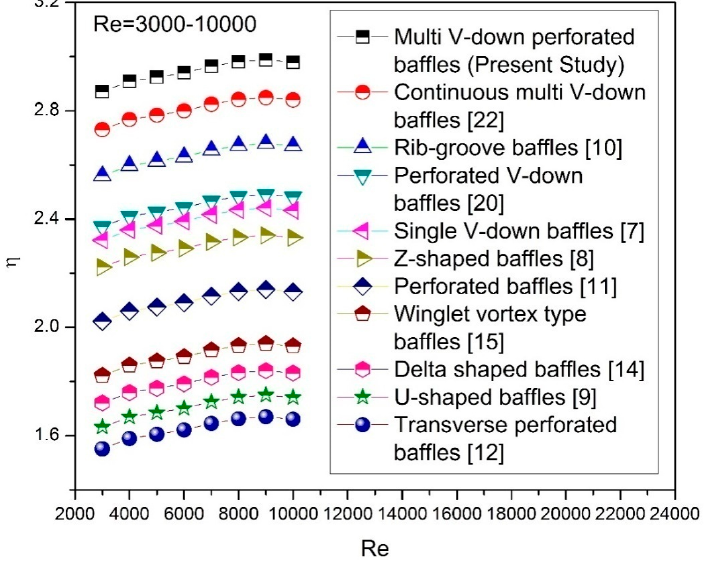
Figure 13. Comparison of various baffle shapes in a rectangular channel.